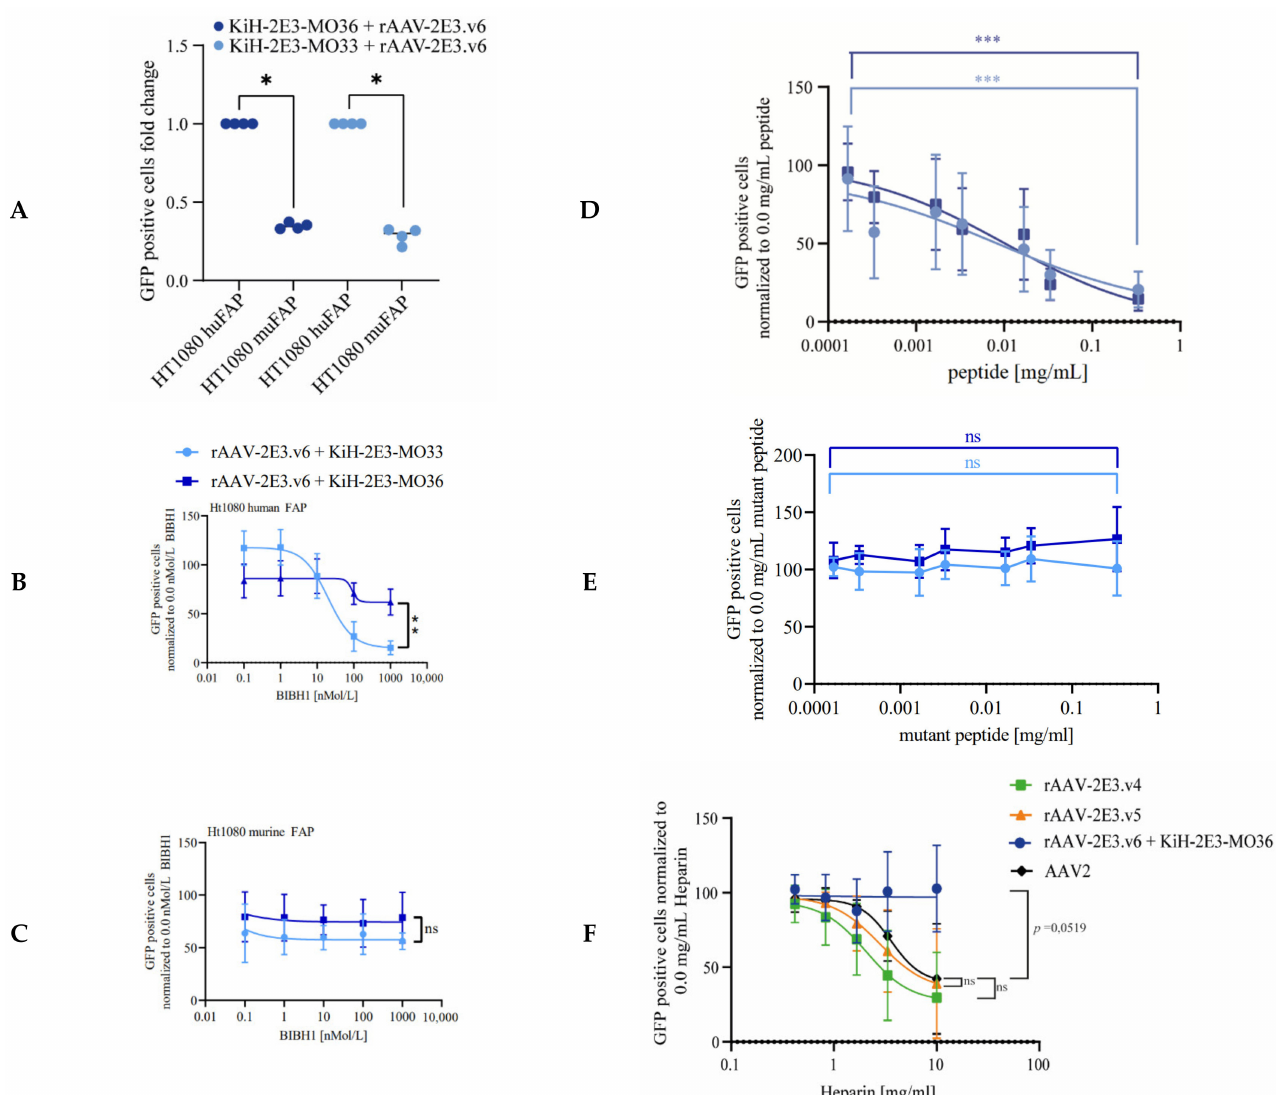
Figure 6. Retargeting efficiency of rAAV-2E3.v6 was affected by competitors and resists heparin binding. Cells were incubated with AAV variants and competitor agents following flow cytometry analysis of GFP expression after 3 days. Data were normalized to transduction levels without competitors. ( A ) Comparison of bispecific antibody induced rAAV- 2E3.v6 transduction of HT1080 cells expressing human or murine FAP. The fold change of GFP expression was calculated. Scattered plot and mean of two independent experiments, Mann–Whitney test, * p < 0.05. ( B ) Specific interaction of rAAV-2E3.v6:bispecific antibodies with FAP was analyzed in competition with increasing concentrations of BIBH1 on huFAP and ( C ) muFAP expressing cells. Data show mean + SD of three independent experiments, Mann–Whitney test, ** p < 0.01, ns = non-significant. ( D ) Specific interaction of rAAV-2E3.v6:bispecific antibodies with 2E3 epitopes was analyzed in competition with soluble 2E3 peptide. Data show mean + SD of four independent experiments, Mann–Whitney test, *** p < 0.001. ( E ) Specific interaction of rAAV-2E3.v6:bispecific antibodies with 2E3 epitopes was analyzed in competition with soluble 2E3 peptide mutation. Data show mean + SD of four independent experiments, Mann–Whitney test, ns = non-significant. ( F ) Transduction of rAAV-2E3.v4, .v5, and v.6:KiH-2E3-MO36 in comparison to AAV2 under increasing concentrations of heparin-sodium in cell culture media of HT1080 huFAP cells. Data show mean + SD of four independent experiments, Mann–Whitney test, ns =